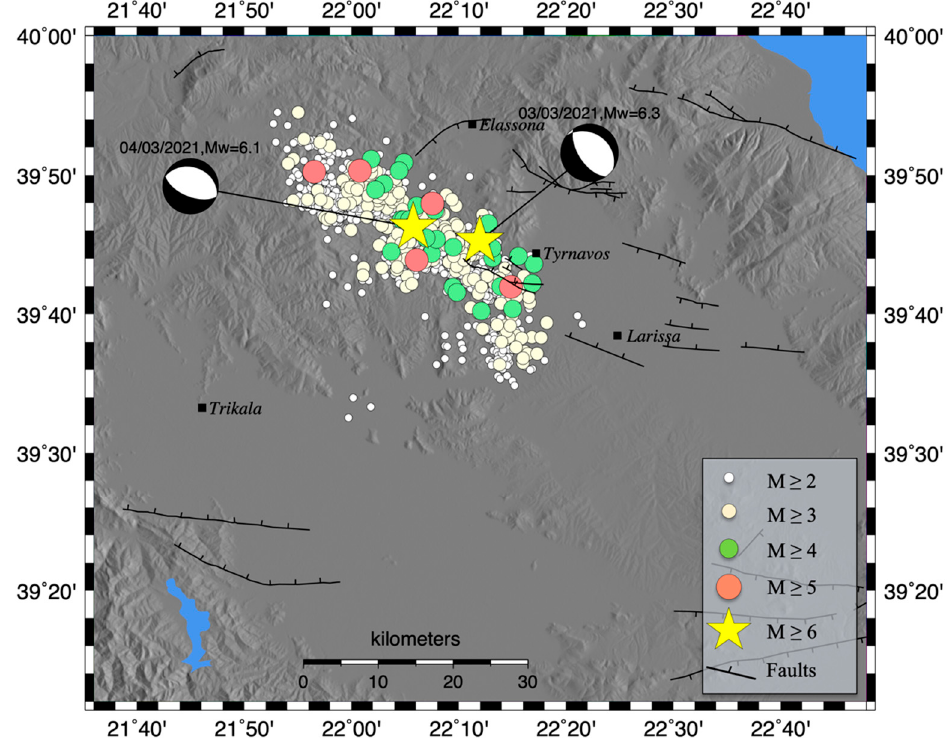
Figure 1. Earthquake epicenters of the aftershock sequence of the 3 March 2021, Thessaly earthquake (yellow star), from 3 March 2021 to 18 April 2021 (M ≥ 2.0). The focal mechanisms of the mainshock and the largest aftershock are also indicated, along with the regional faults shown with black solid lines (for details see the text).